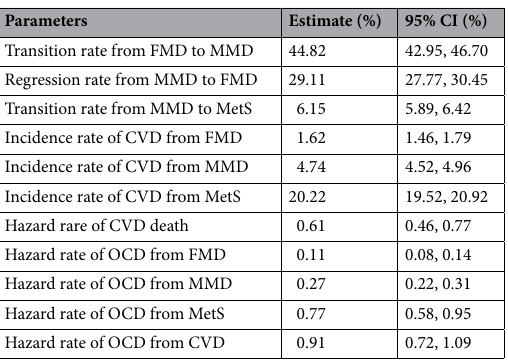
Table 3. Estimated results of disease progression history for RMRC, CVD and CVD